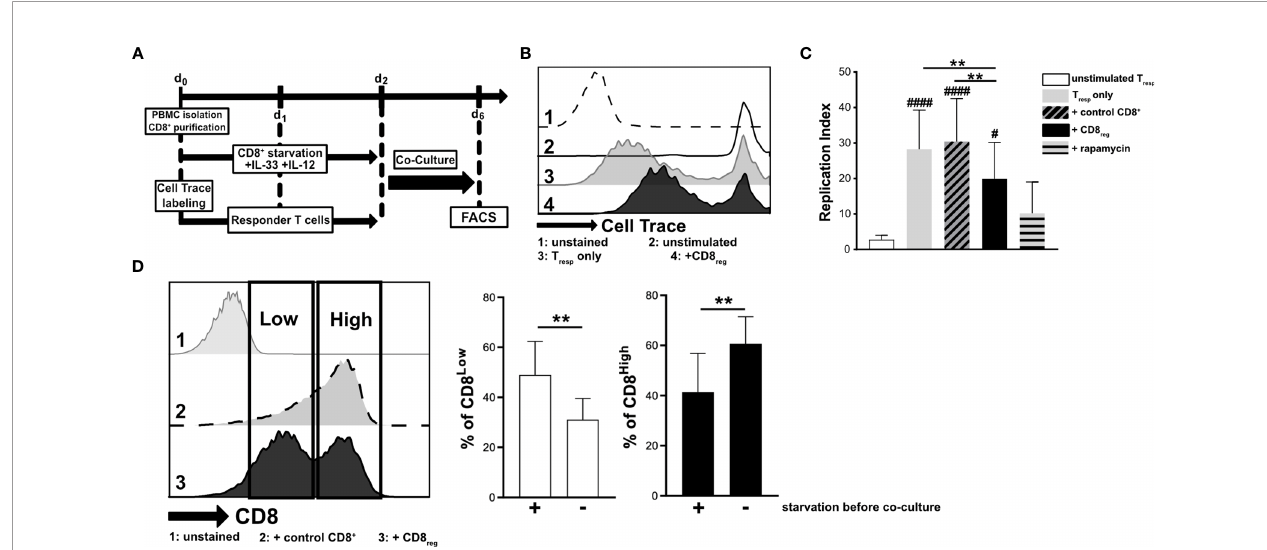
FIGURE 3 | Starved regulatory CD8 + T lymphocytes suppress the proliferation of donor-speci fi c responder T cells during co-culture in vitro . (A) Experimental timeline for transwell in vitro suppression with regulatory CD8 + T lymphocytes (CD8 reg ) and violet cell trace labeled responder T lymphocytes (T resp ). For the differentiation of CD8 + T lymphocytes and proliferation of labeled T resp using a TCR stimulation cocktail ( a CD3/28/2), cells were separately cultivated for 2 days. Co- cultivation of both lymphocyte populations started on day 2 of culture for 4 days before analyzing the proliferation of T resp using fl ow cytometry. (B) Exemplary histograms showing the proliferation of T resp under different conditions after co-culture. 1: unstained control 2: unstimulated T resp control, 3: T resp proliferation alone, 4: Co-Culture with regulatory CD8 + T lymphocytes. (C) Proliferation of T resp was quanti fi ed using the proliferation modelling from FlowJo software. The replication index indicates the fold-expansion dividing cells (expansion capability). (D) Representative histograms of CD8 + T lymphocytes showing CD8 Low (Low) and CD8 High (High) subpopulations after co-culture (day 6). 1: unstained control, 2: co-culture with CD8 + T cells with no starvation beforehand, 3: co-culture with regulatory CD8 + T cells (starved, +IL-33, +IL-12). (B – D) All data are obtained from n = 9 donors of three independently performed experiments. # for comparisons to the unstimulated control # p ≤ 0.05, #### p < 0.0001, using Friedman test with Dunn´s post-test. **p < 0.01, using Wilcoxon matched pairs signed rank